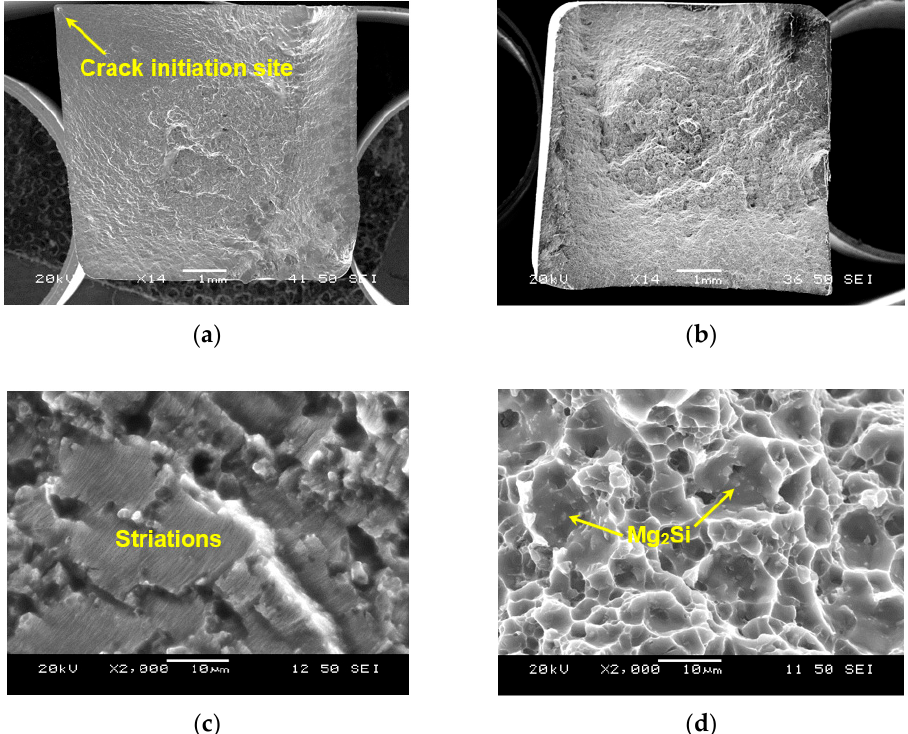
Figure 14. Fractographs of the samples fatigued at a strain amplitude of ( a ) 0.2% and ( b ) 0.6%, respectively; ( c ) fatigue crack growth region in the 0.2% sample and ( d ) final rapid fracture area in the 0.6% sample showing the embedded Mg 2 Si particles.